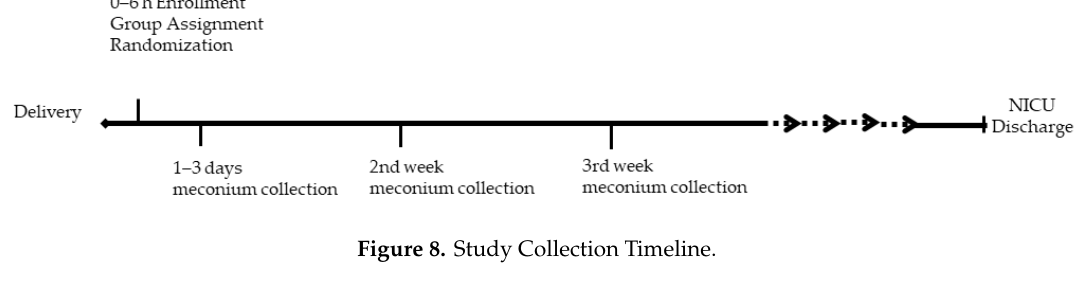
Figure 9. Group schematic. * Represents the total after 3 were bailed from Group C2. 4.2. Stool Sample Collection Weekly fecal samples, including first meconium when possible, were collected from the patient diaper into a sterile container and stored at −80 °C. For protein normalization, stool samples were first suspended in 5 mM Ammonium Acetate (400 μL) and then homogenized using a cell disrupter (30 s, 3 times). Protein concentrations were determined with a Qubit (ThermoScientific, Waltham, MA, USA). All samples were normalized to a protein concentration of 500 µg/mL at 25 µL. The normalized samples were spiked with 5 µL of internal standards containing Creatine-D3, L-Leucine- D10, L-Tryptophan-2,3,3-D3, L-Tyrosine Ring- 13 C6, L-Leucine 13 C6, L-Phenylalanine Ring- 13 C6, N- BOC-L-tert-Leucine, N-BOC-L-Aspartic Acid, Propionic Acid 13 C3, Succinic Acid-2,2,3,3-D4, Salicylic